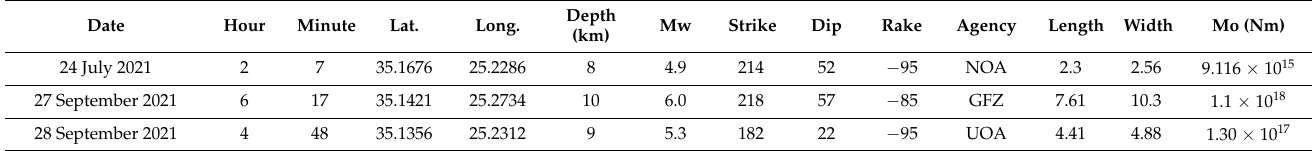
Table 5. Focal parameters of Mw = 4.9, Mw = 6.0 and Mw = 5.4